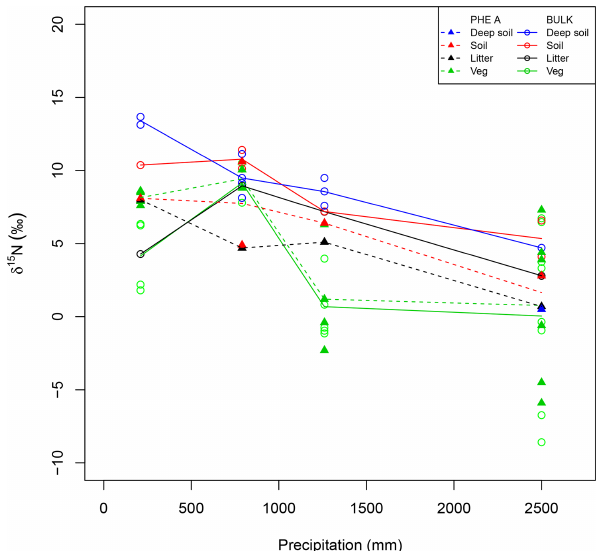
Figure 4. δ 15 N of pheo a (green) and chlorophyll a (orange) cor- relates linearly with bulk leaf δ 15 N. The linear model for δ 15 N of pheo a as a function of bulk leaf δ 15 N is printed as a dashed line. A line with a slope of 1 (solid line) is plotted for reference. Each sample’s species is identified with a label: CC: C. ciliaria (C 4